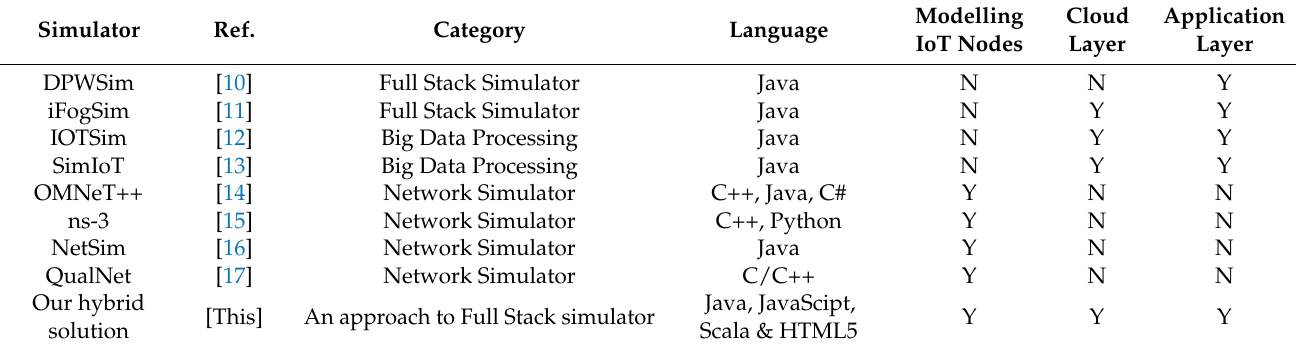
Table 1. Summary of tools to support Internet of Things (IoT) simulation. Y: Supported, N: Not Supported. Simulator